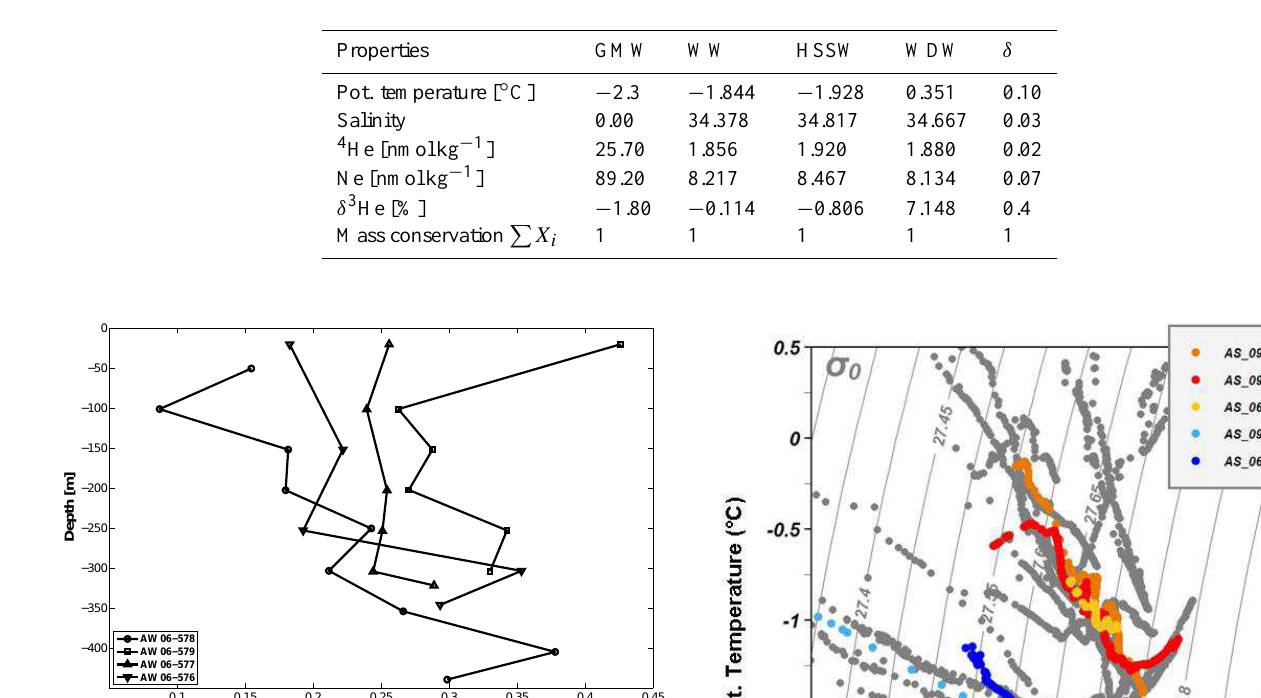
Table 2. Source water properties used for the Optimum Multiparameter Analysis (OMP). GMW = Glacial Melt Water, WW = Winter Water, HSSW = High Salinity Shelf Water, WDW = Warm Deep Water. The δ is used to determine the weight w = σ(p i ) 2 /δ .